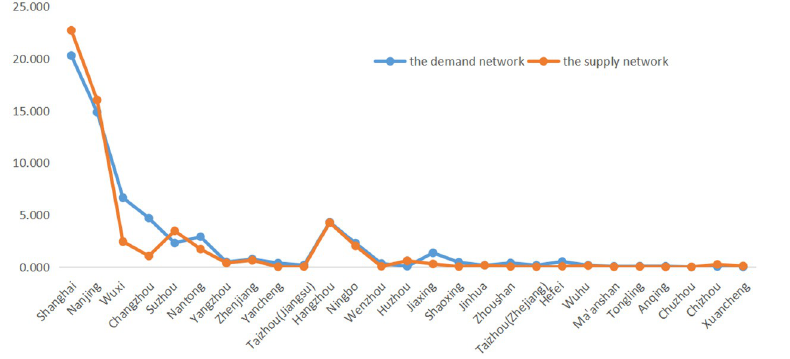
Fig 6. The betweenness centrality index of the demand and supply